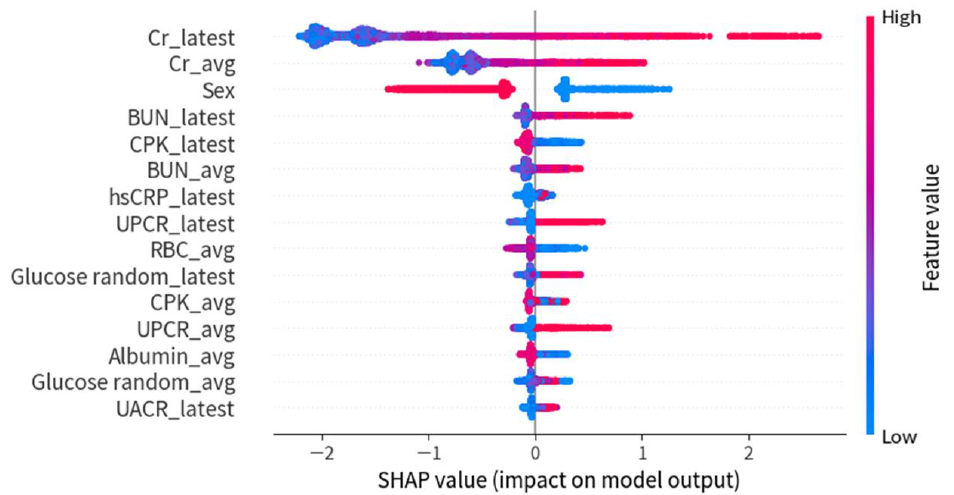
Figure 4. SHAP summary plot of the top 15 features for the XGBoost model in experiment 1.